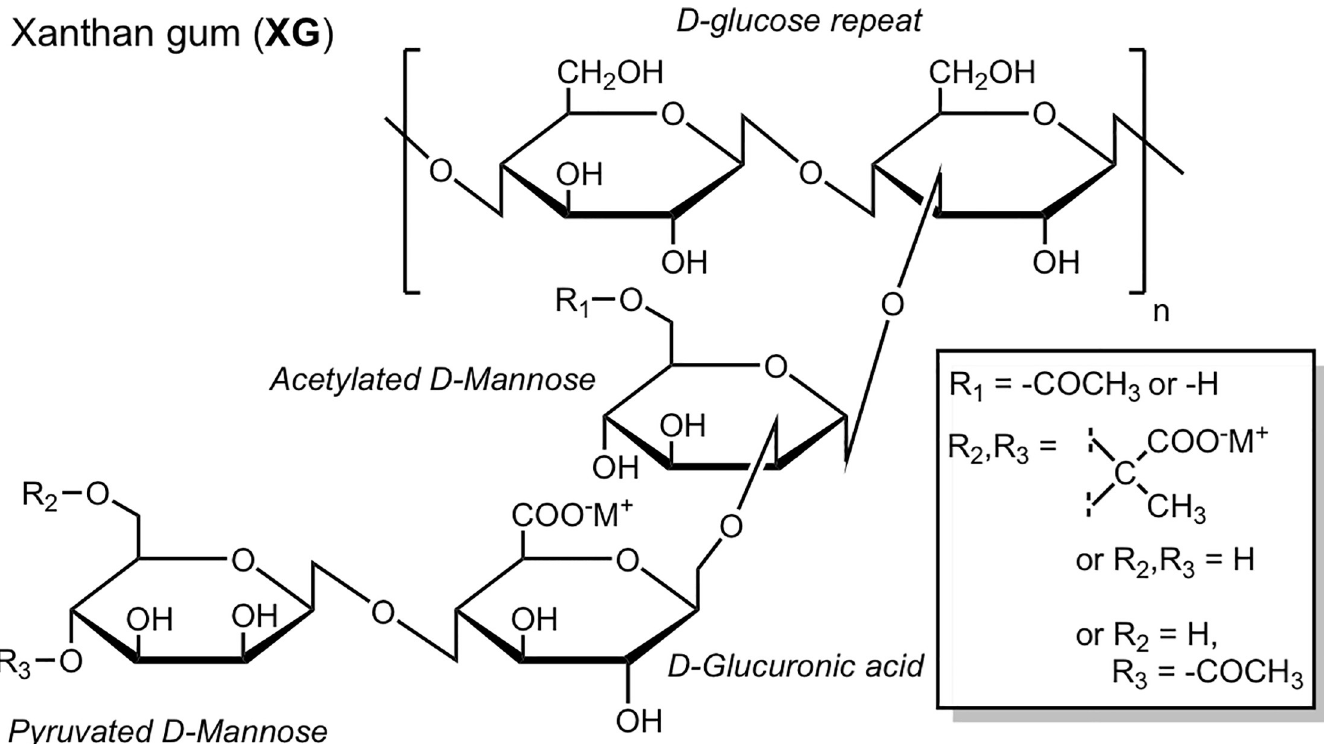
Fig 1. Structure of xanthan gum (XG) with sub-structural components denoted. For XG, a majority of R1 groups on the inner mannose residue are 6-acetylated and an estimated 40% of the terminal mannose residues are 4,6-pyruvated (R2, R3).